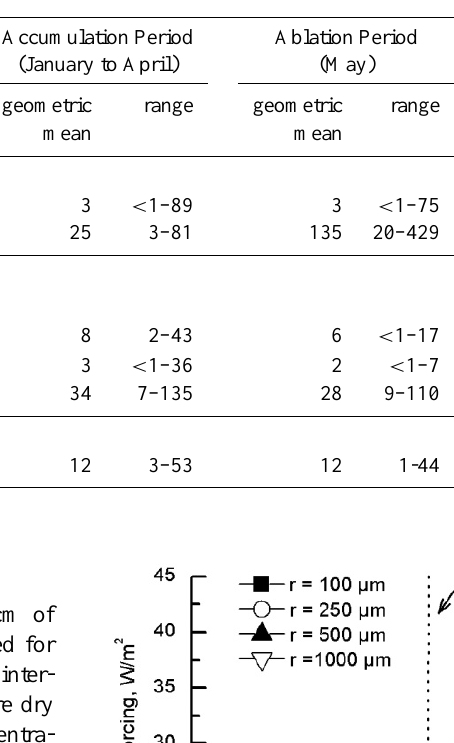
Table 1. Measured concentrations of rBC, soluble ions, and continental dust.